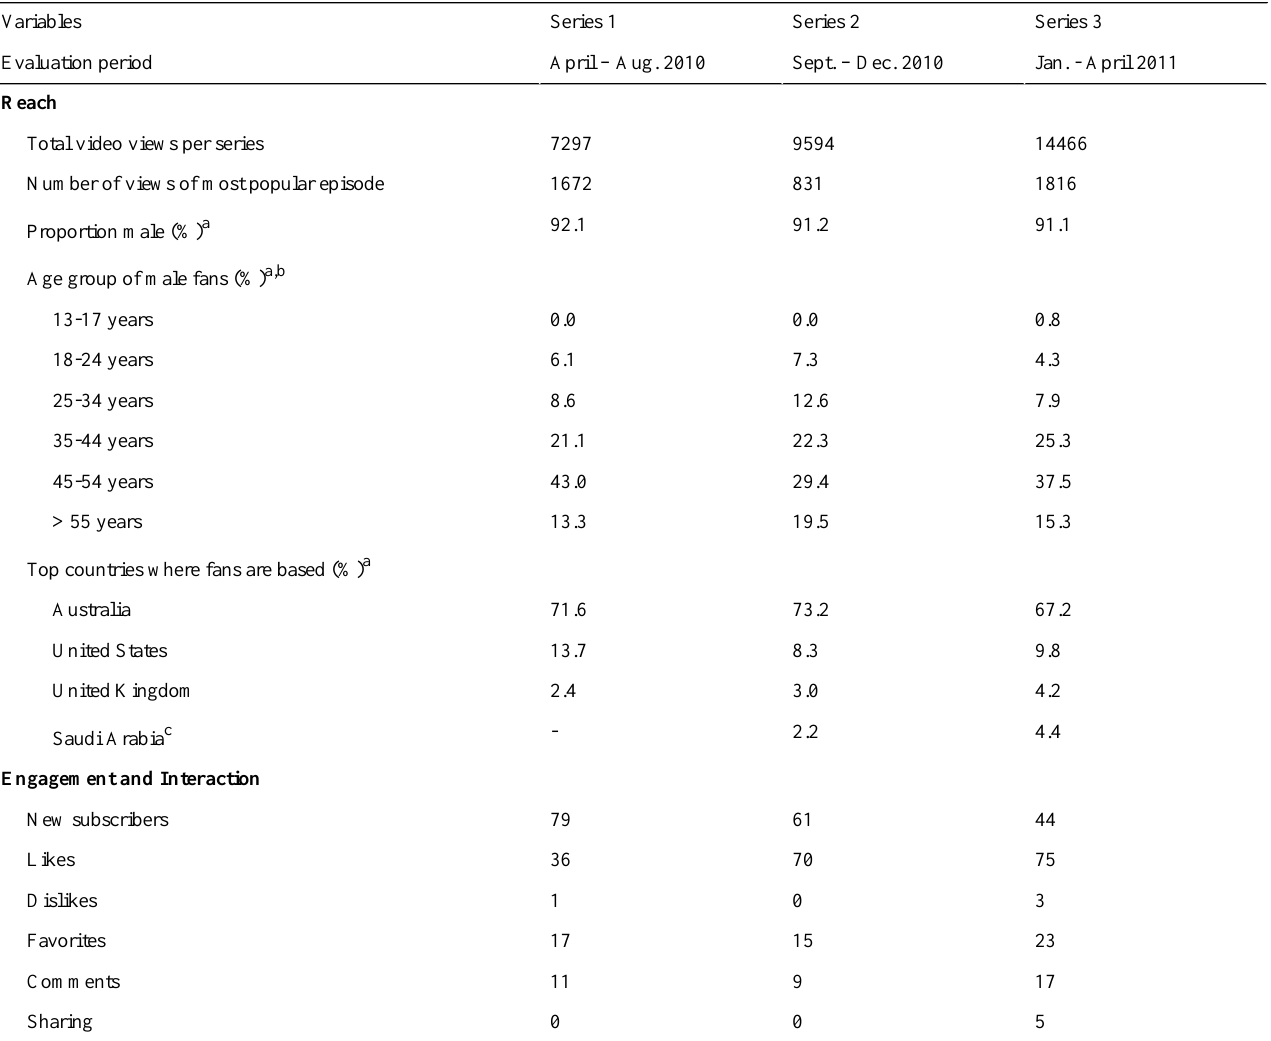
Table 2. Key metrics from the QAF YouTube page usage statistics per series (source: YouTube insights